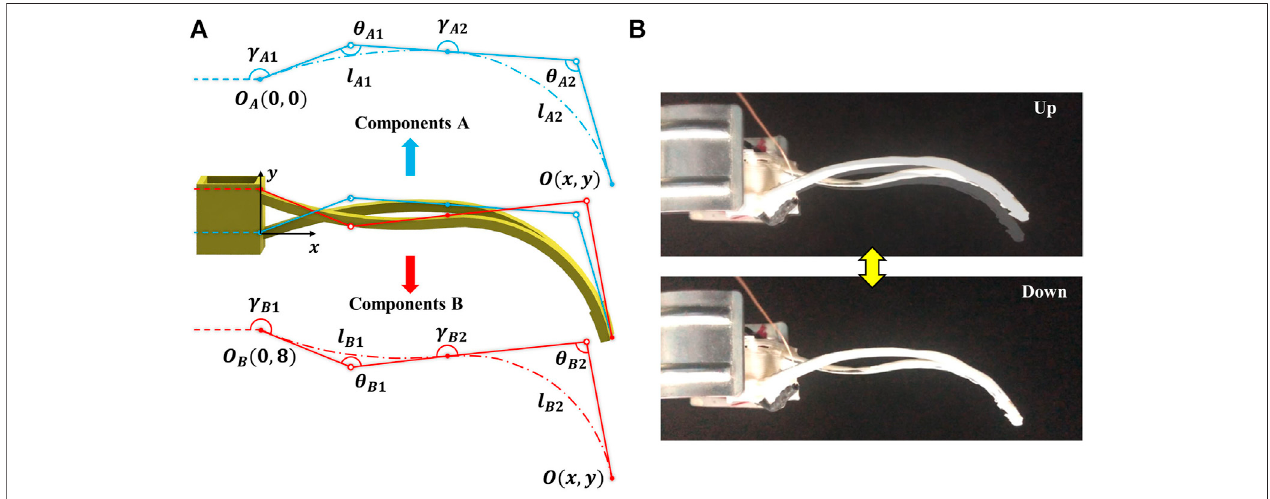
FIGURE 5 | Results of complex sample consisting of two parallel components. (A) Geometric analysis of parallel components. (B) Actual deformation of sample.